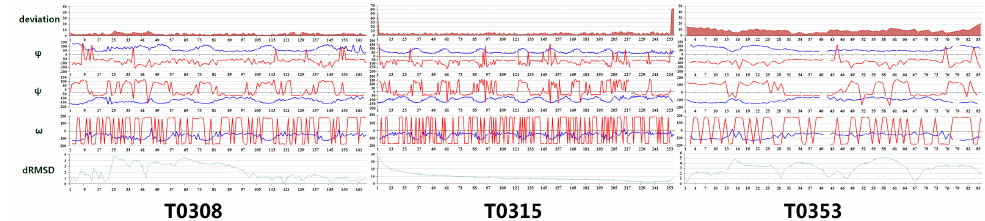
Figure 14. T0308, T0315, T0353 changes in deviation, torsion angle, and dRMSD . Blue is the predicted structure, red is the actual structure.